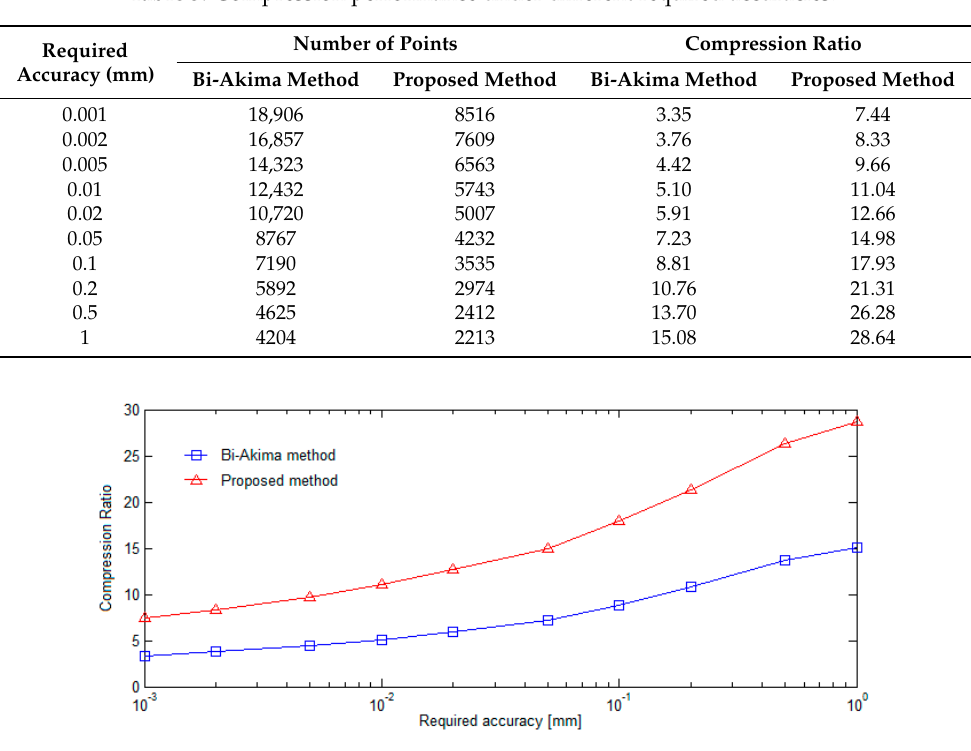
Table 3. Compression performance under different required accuracies.